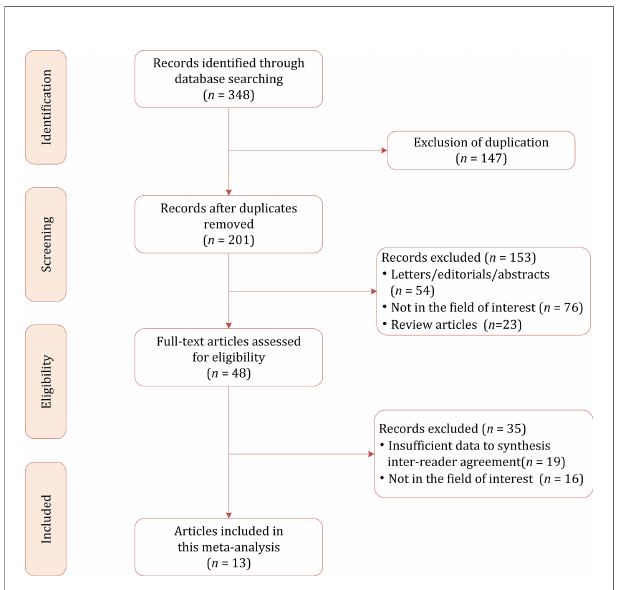
FIGURE 1 | Study selection process for this systematic review and